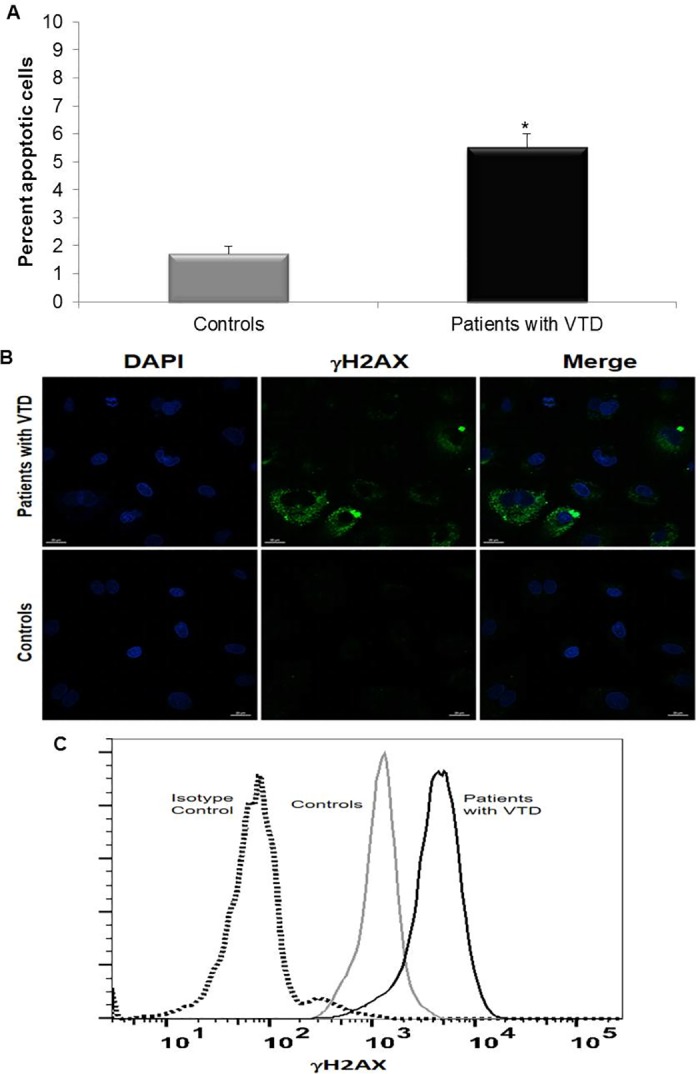
Apoptosis in ECFC-ECs obtained from peripheral blood of controls and patients with VTD.The figure shows the percentage of ECFC-EC annexin V-FITC positive (A) and the presence of DNA damage evaluated by the expression of γH2AX histone by immunofluorescence (B) as well as flow cytometry analysis (C), in passage 4. Results are expressed as mean ± standard deviation of three independent experiments. *P = 0.002 for annexin expression.